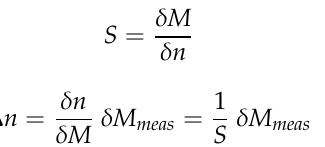
Figure 2. Outline of the experimental setup used to test the plasmonic sensors.